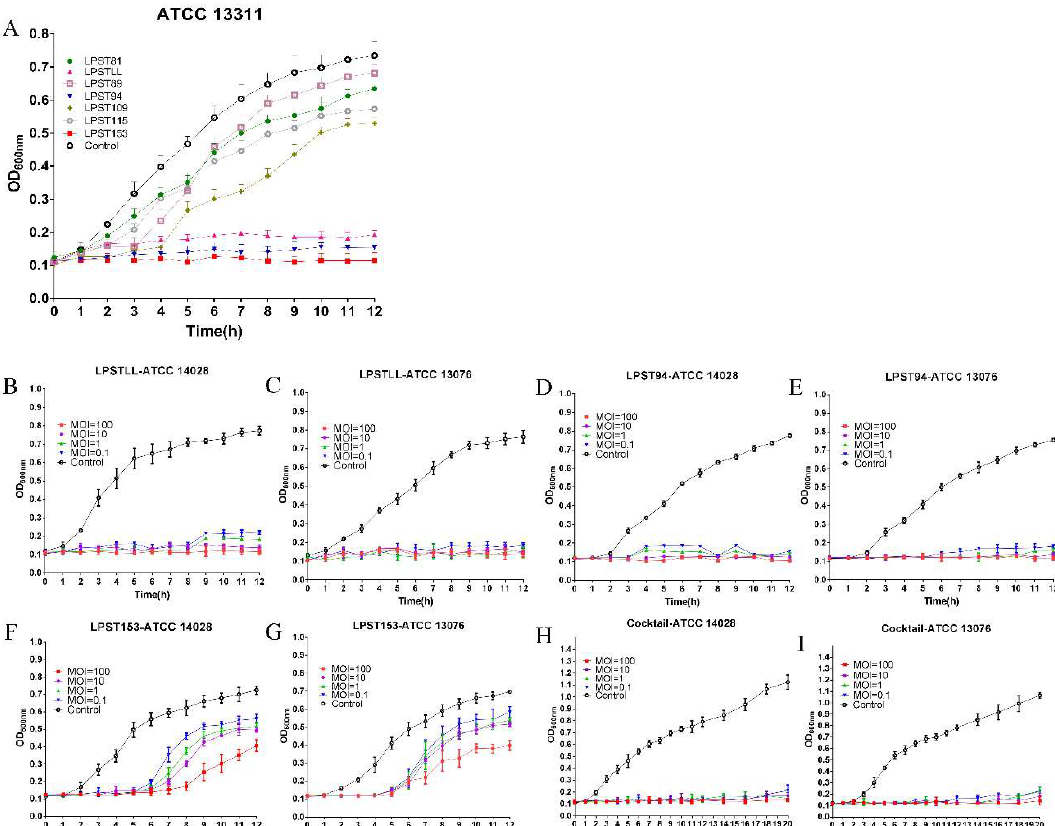
Table 3. Efficiency of plating (EOP) by phages (LPSTLL, LPST94, LPST153 and cocktail) against different Salmonella serovars.